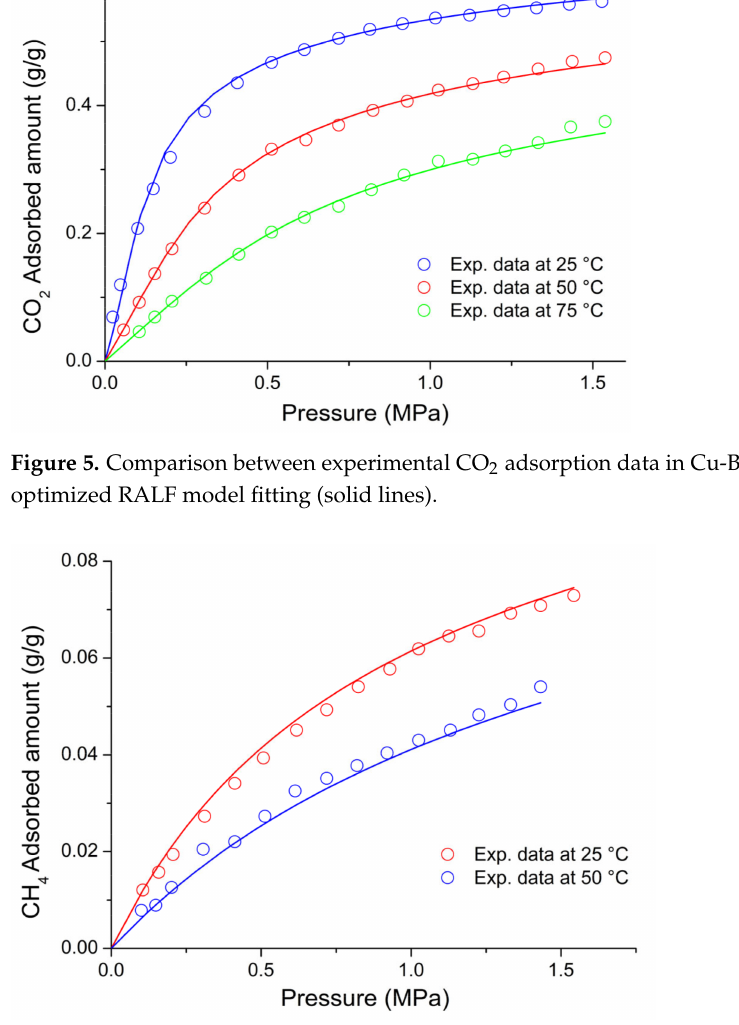
Figure 6. Comparison between experimental CH 4 adsorption data in Cu-BTC [48] and simultaneous optimized RALF model fitting (solid